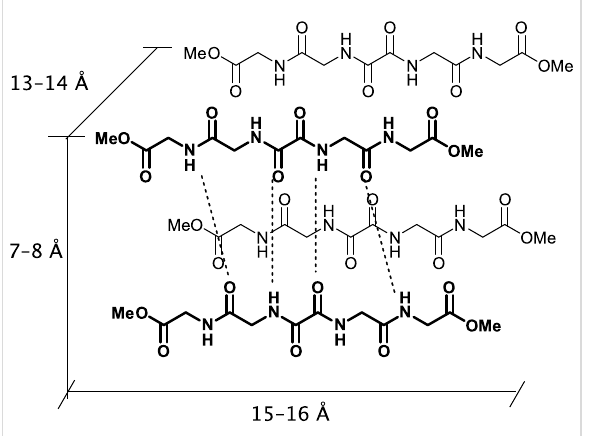
Figure 11: Schematic presentation of the proposed ( S,S )- 1b and ( S,R )- 1b basic packing model based on XRPD, 1 H NMR, FTIR and molecular modeling results.